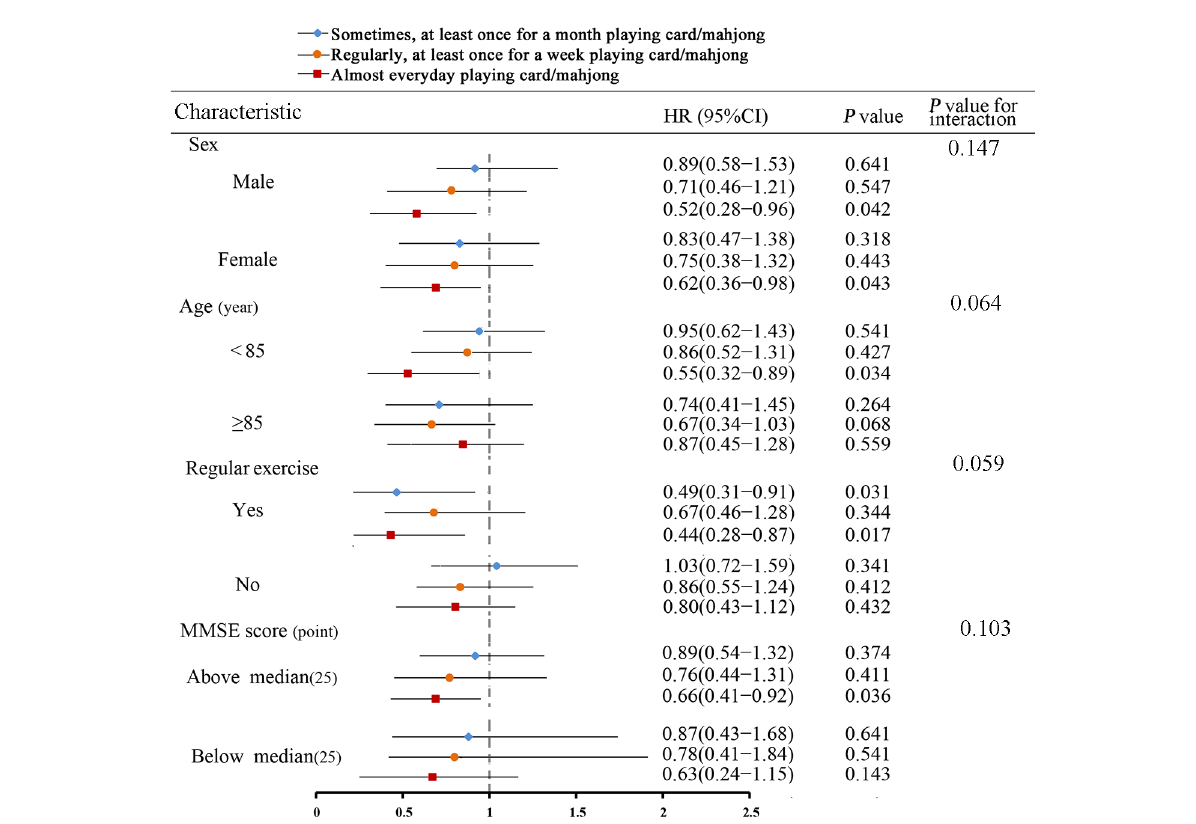
FIGURE2 Hazard ratios (HRs) and confidence intervals (CIs) for the association between frequency of playing cards/mahjong and dementia, with rarely or never playing cards/mahjong as a reference group, by baseline sex, age, regular exercise, and MMSE score, adjusting for baseline age, sex, education, household income, marital status, smoking status, drinking status, exercise, BMI, living with family members, hypertension, diabetes, and MMSE